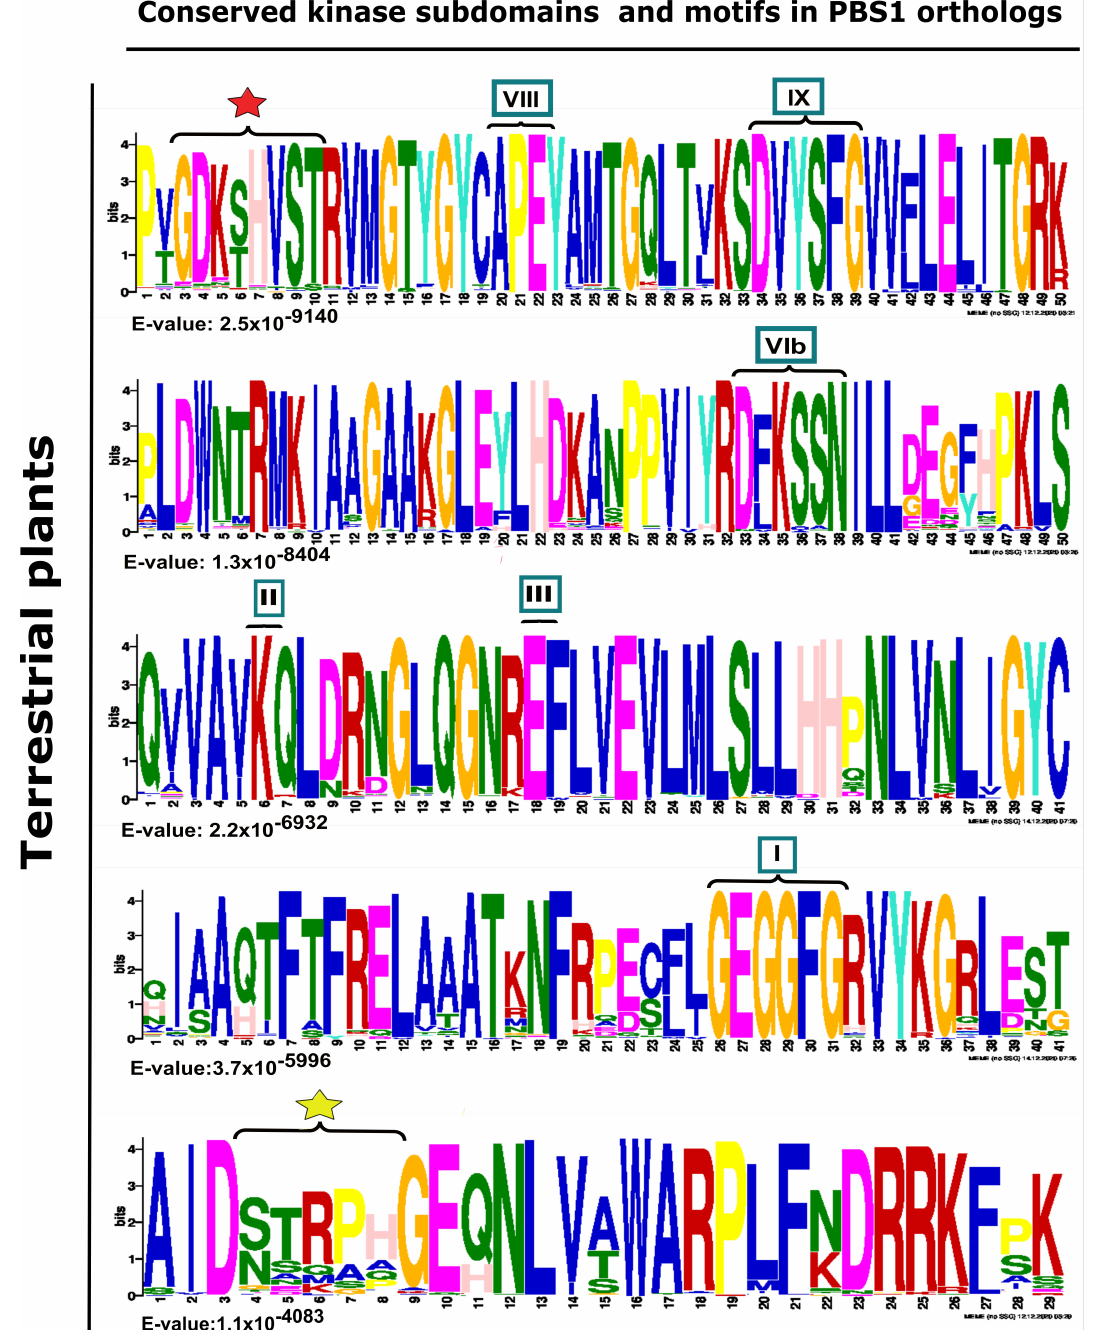
Figure 3. Analysis of conserved kinase subdomains and important motifs in PBS1 orthologs in terrestrial plants. Sequence logo representation is shown in multiple sequence alignment of 182 sequences with high similarity to Arabidopsis PBS1 from monocots (37/182), eudicots (117/182), bryophytes (7/182), charophytes (2/182), gymnosperms (7/182), lycophytes (7/182), liverwort (1/182), and pteridophyte (4/182). The domains are ordered from lowest to highest expectation (E) values. The conserved kinase subdomains are labeled with Roman numerals. Subdomain I: GxGxxG; II: K; III: E; VIb: DxxxxN; VII: DFG; VIII: APE; IX:DxxxxG; XI: R. The AvrPphB cleavage site GDK is labeled with a red star, and the recognition motif required for RPS5-mediated resistance is labeled with a yellow